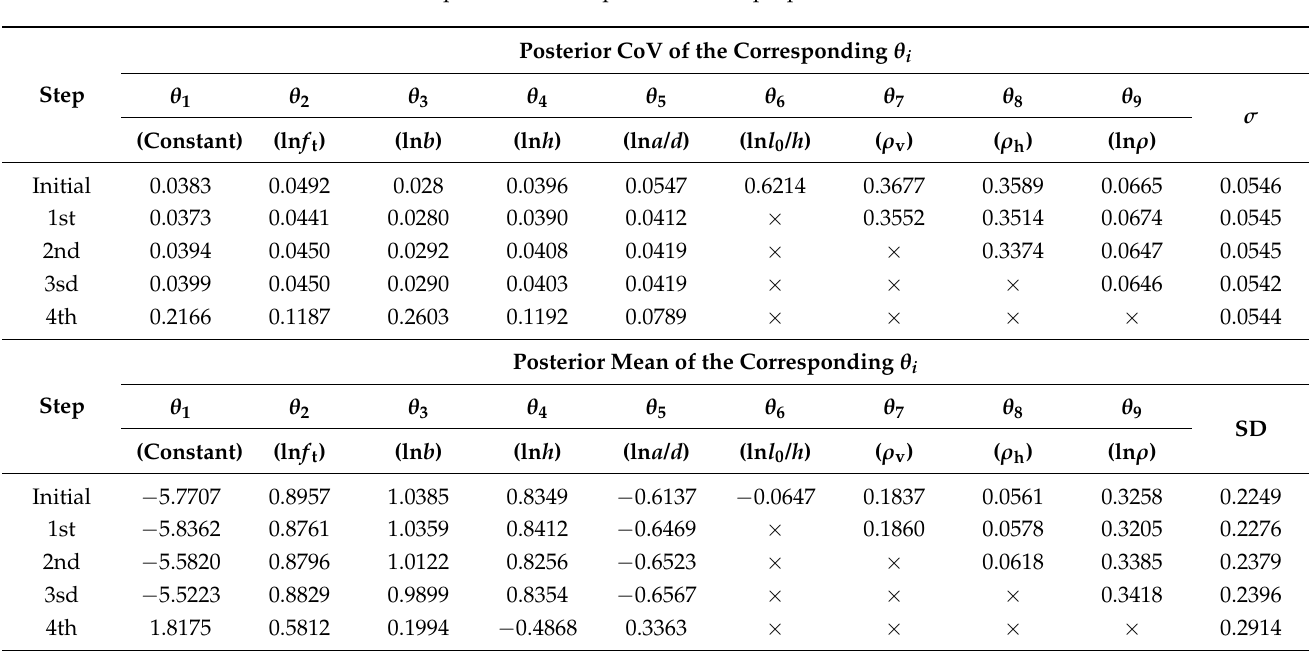
Figure 3. Simulation results of parameters. Table 4. Step-wise removal process for the proposed